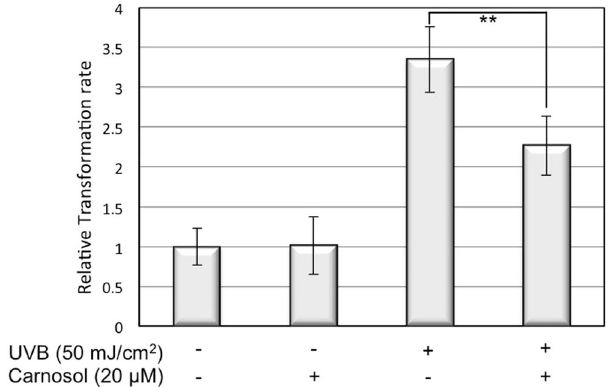
Figure 5. Carnosol decreases HaCaT transformation rate upon UVB radiation. HaCaT cells were exposed to 10 mJ/cm 2 UVB radiation every 48 hours for 14 days. Cells were then collected and equal number of cells was re-seeded into 96-well plate with soft agar. After 10 days of incubation, cells were stained and the fluorescent intensity was determined. ** p < 0.01.